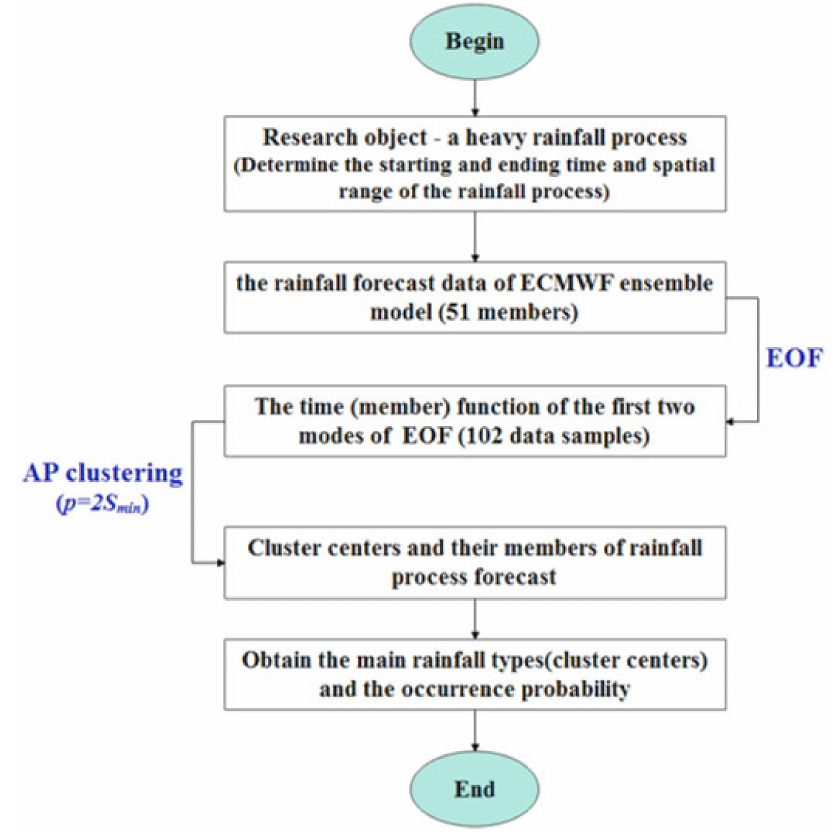
Figure 1. Technology roadmap of EOF_AP clustering